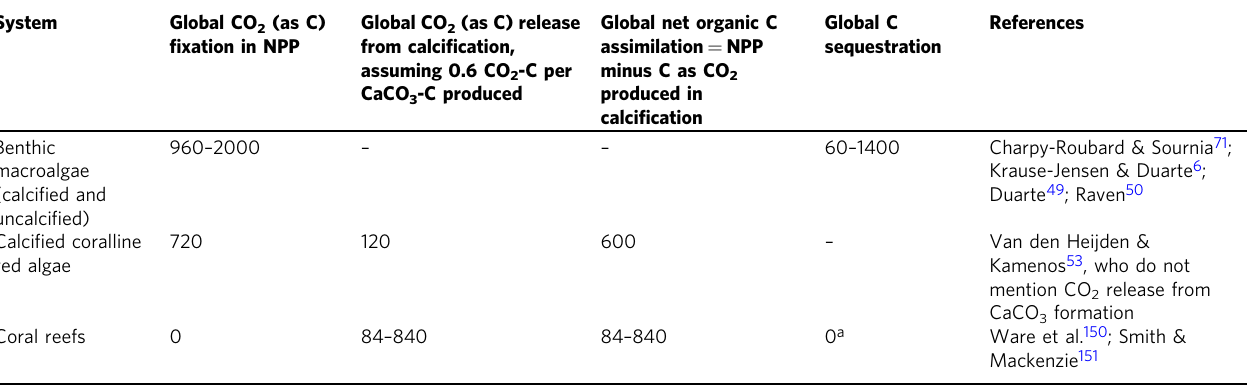
Table 2 Estimates of global net primary productivity, CO 2 release from calci fi cation and C sequestration (Tg C yr − 1 ) for